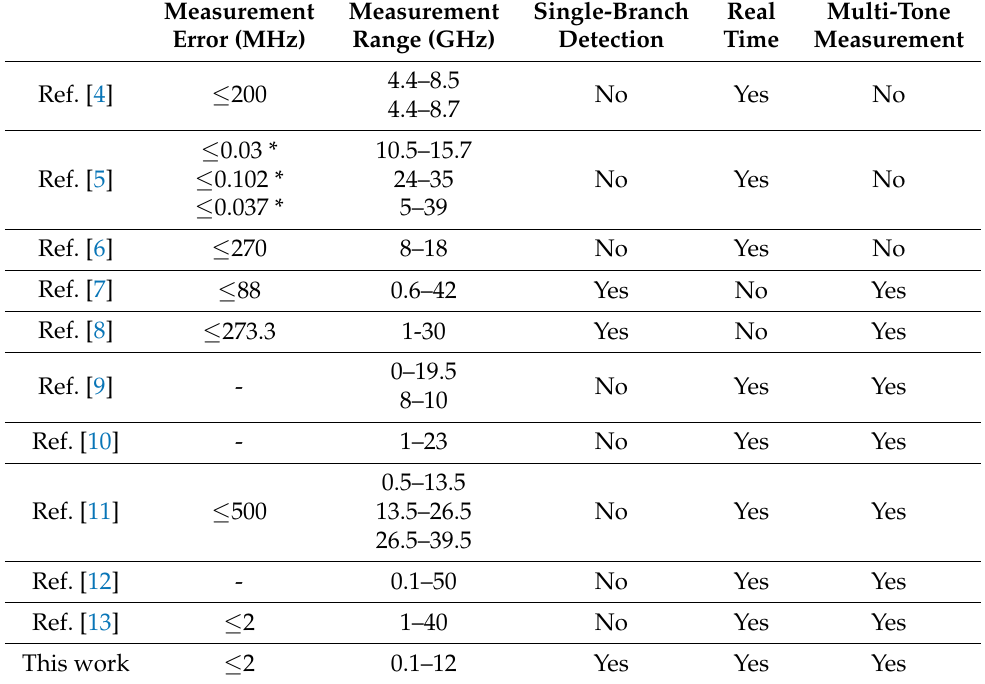
Table 1. Performance